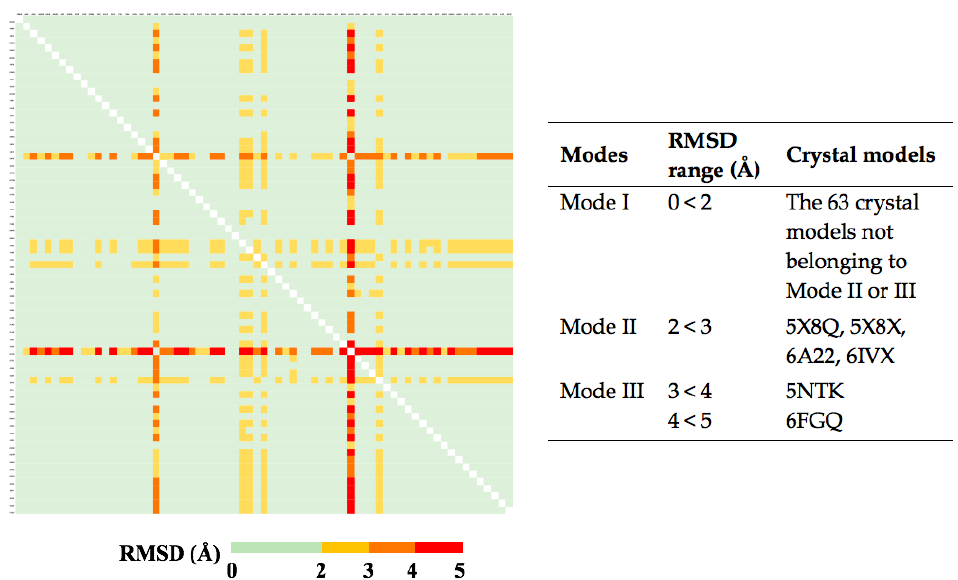
Figure 5. Conformational comparison of ROR γ orthosteric pockets induced by 69 inverse agonists. For each ligand-bound LBD, the H1–H11 (265–490 a.a.) portion was extracted for pairwise comparison. The root-mean-square deviation (RMSD) value between two models was measured in the C α manner by YASARA and then labeled on the figure based on the color scale. According to their RMSD values, the conformations of the pockets were assigned into three modes, which are briefly listed in the right table. The detailed list can be found in Supplementary Table S3.